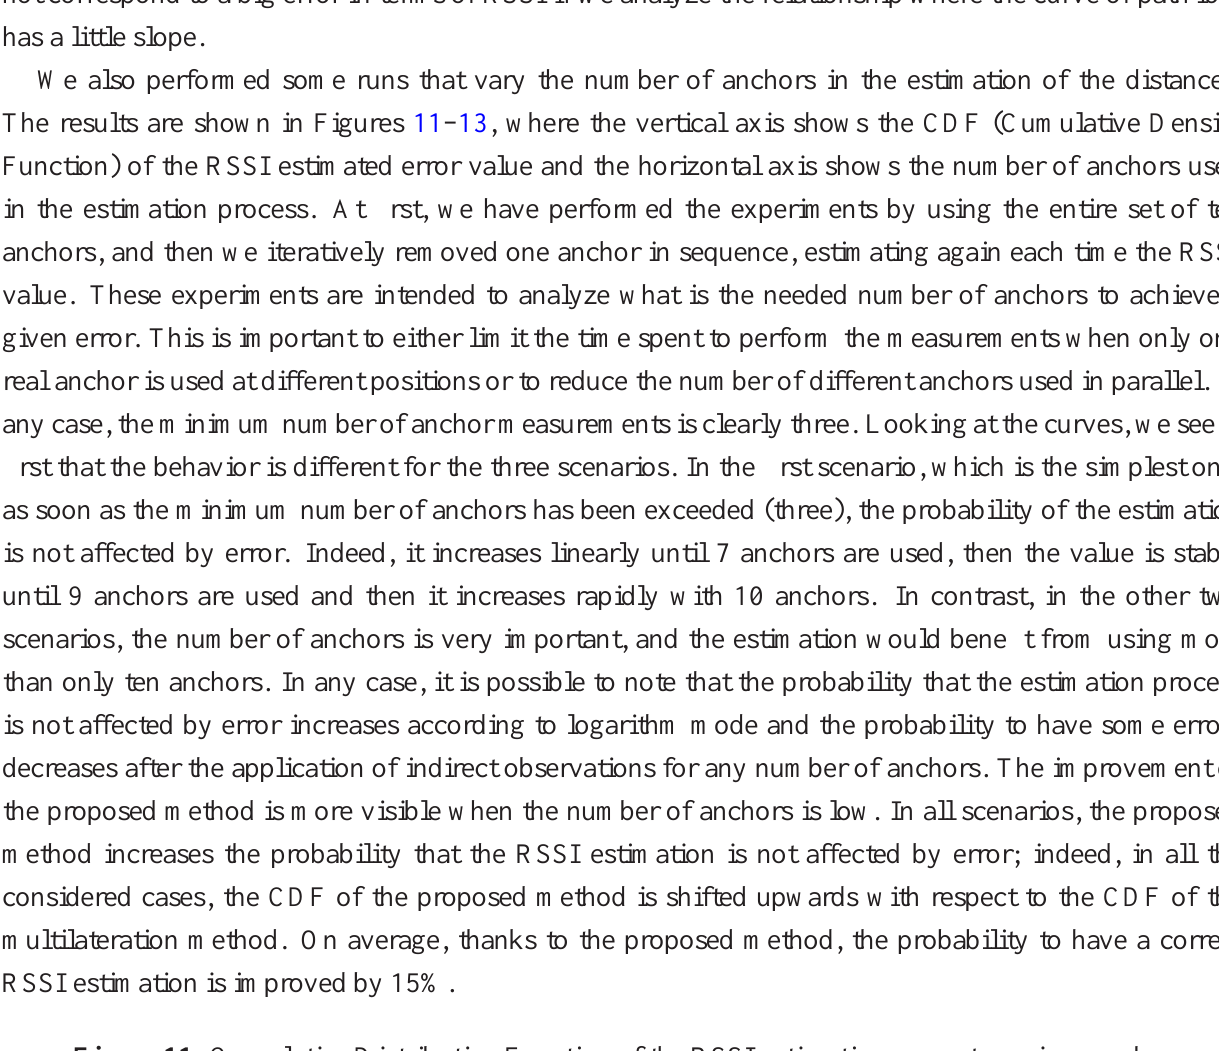
Figure 11. Cumulative Distribution Function of the RSSI estimation error at varying number of anchors for the office